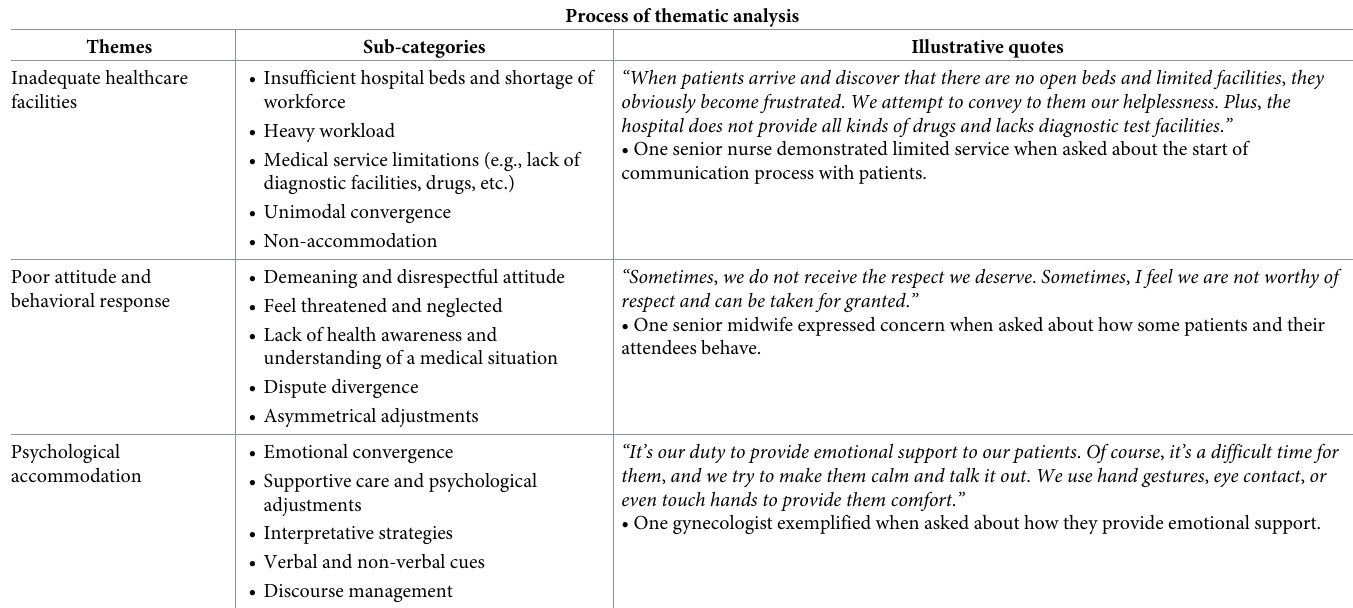
Table 1. Thematic